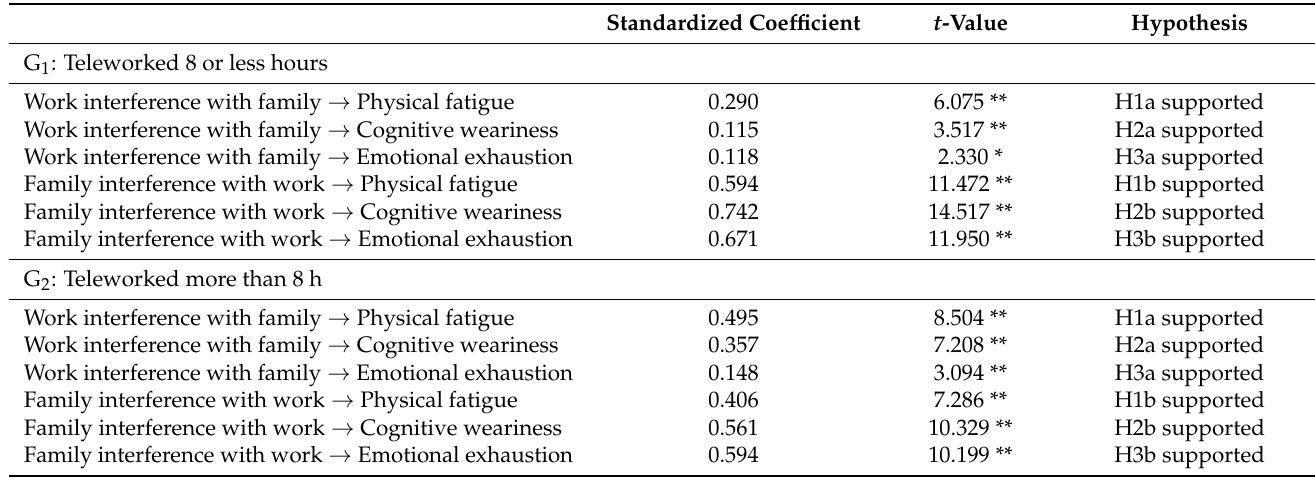
Table 6. Standardized path coefficients for structural model (G 1 and G 2 subsamples).